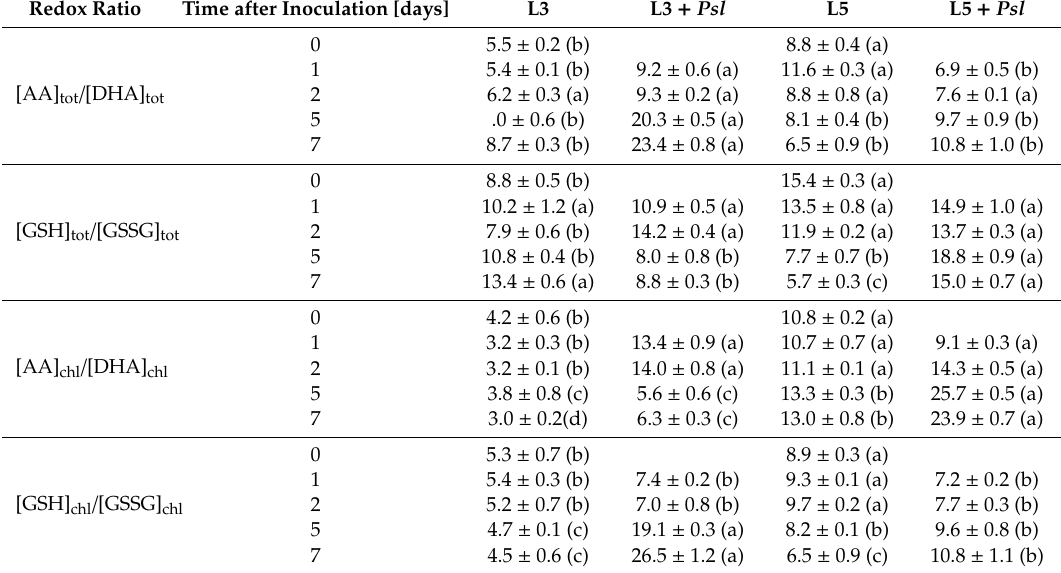
Values are means of four replicates ( ± SD). Di ff erent letters (a–c) indicate significant ( p ≤ 0.05) di ff erences between experimental variants within a given time point. Table A2. Redox ratios for ascorbate and glutathione defined as the quotient of reduced (AA, GSH) to oxidized (DHA, GSSG) content form in leaf (tot) and chloroplast (chl) extracts. Redox